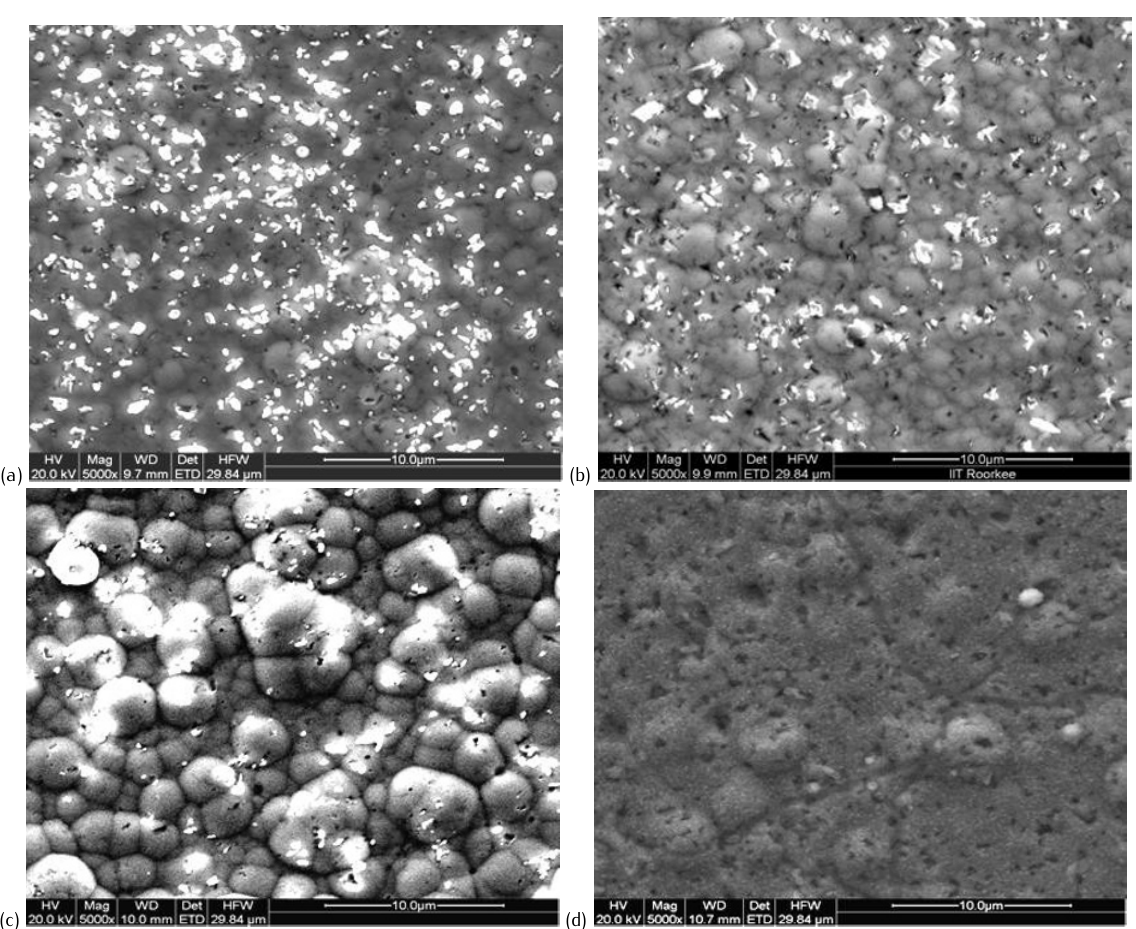
Figure 1. SEM micrograph of NiPPA nano-dispersion coating (a) as plated and heat treated at (b) 200 ◦ C (c) 400 ◦ C (d) 600 ◦ C.